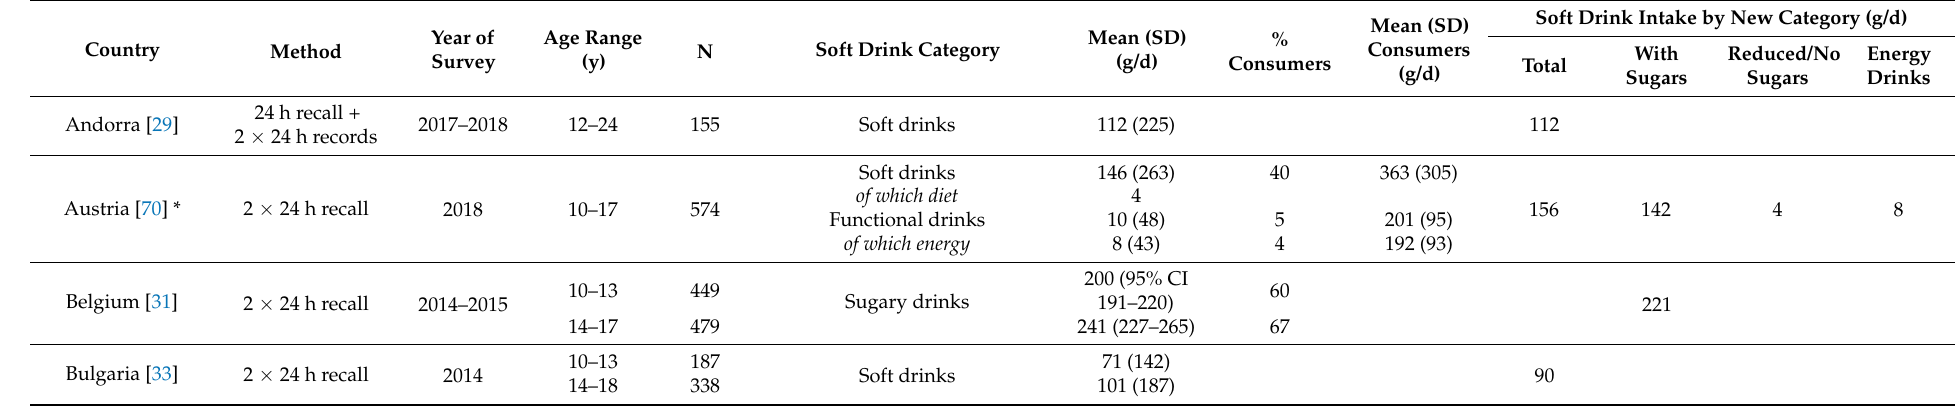
Table 4. Soft drink intake in adolescents (~11–17 y) in the WHO European Region, as reported in National Dietary Surveys and by new